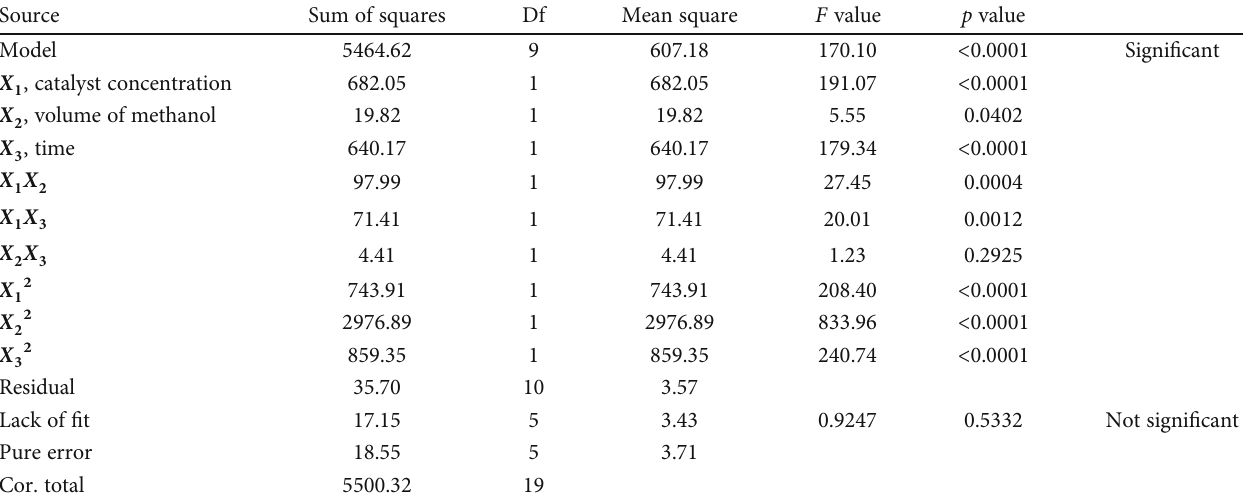
Table 6: ANOVA for Response Surface Quadratic